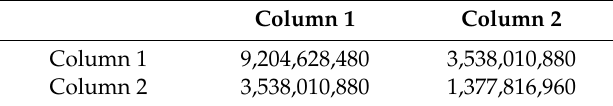
Table A8. Covariance matrix (see Table 1).